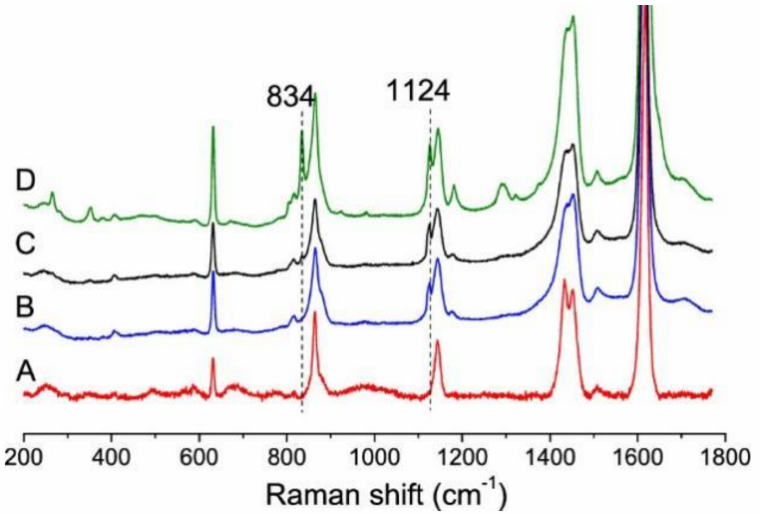
Figure 11. Raman spectra of fresh UiO-66 (A) and H 2 O 2 -treated UiO-66: (B and C) 30- and 90-fold excess of H 2 O 2 followed by washing with MeCN; (D) 60-fold excess of H 2 O 2 without washing. Reprinted with permission from ref. [109]. Copyright 2020 American Chemical